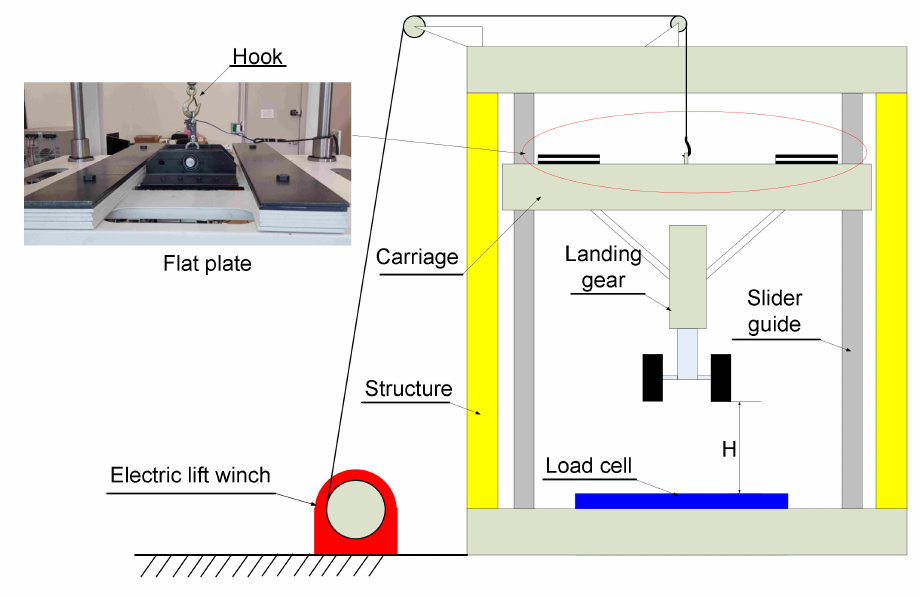
Figure 1. Structure of drop test